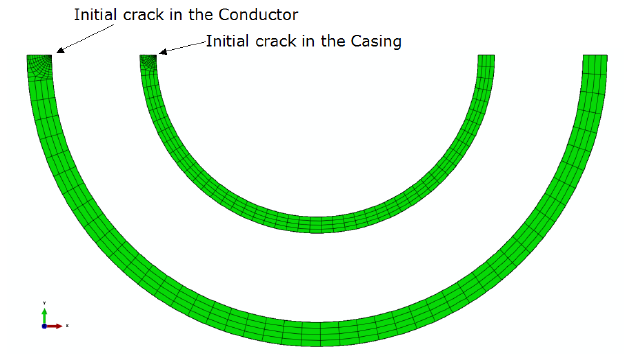
Figure 14: Location of initial cracks (half model)